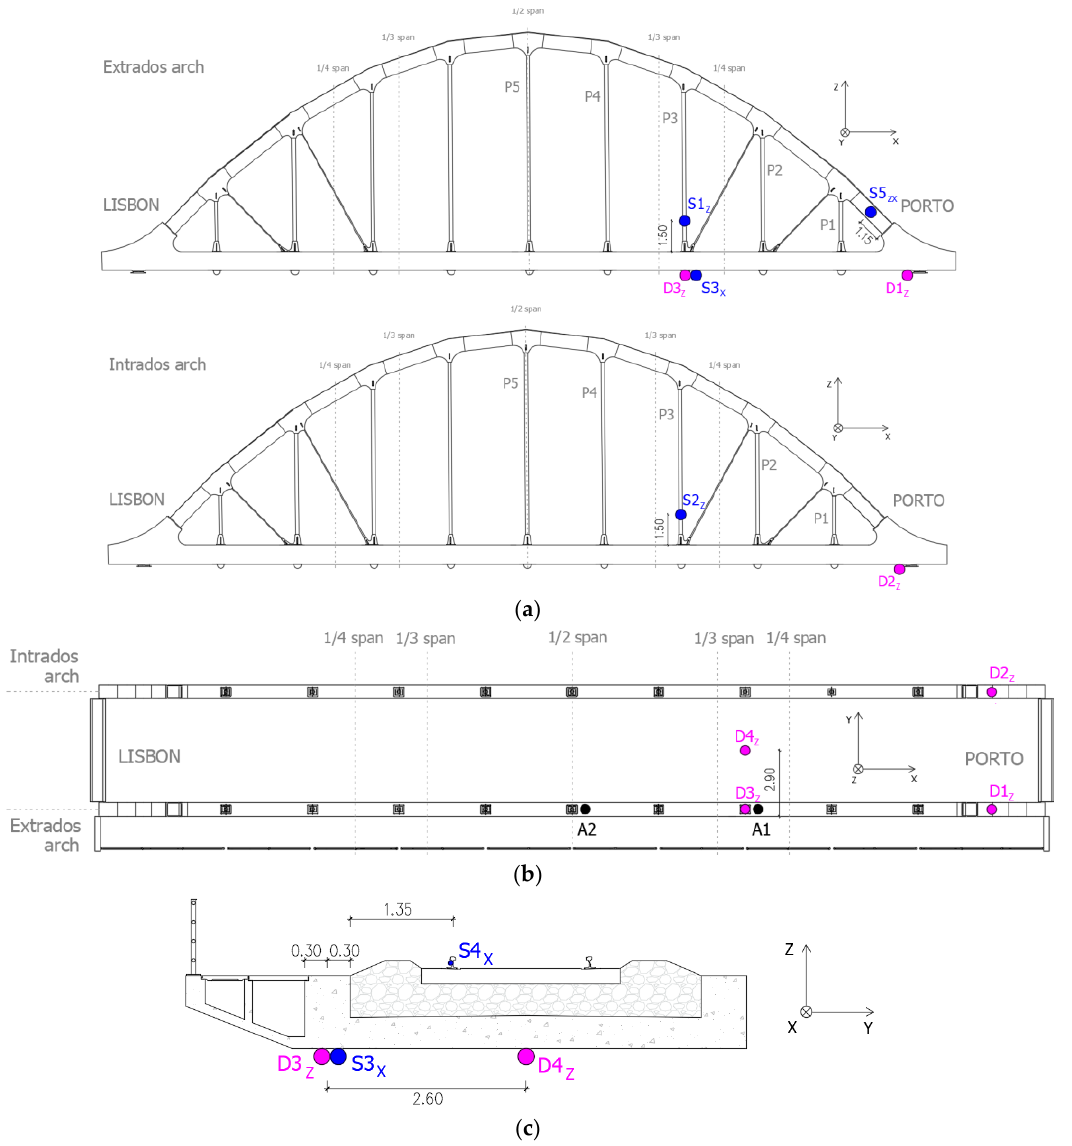
Figure 12. Measuring points in the dynamic test under railway traffic: ( a ) lateral views of the arches (extrados and intrados); ( b ) plan view of the deck; ( c ) deck cross-section (between 1/3 and 1/4 span).